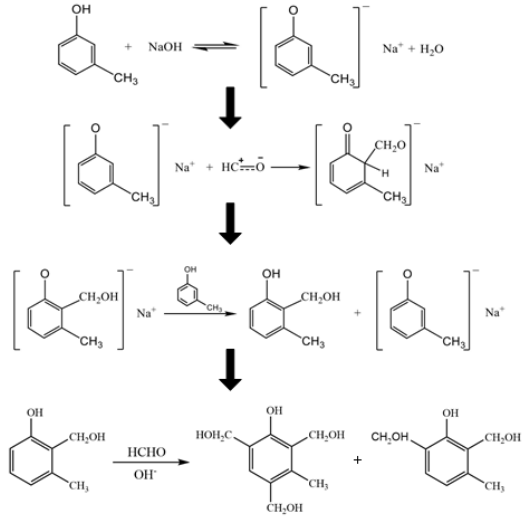
Figure 1. The synthesis scheme of m-cresol/formaldehyde resin.